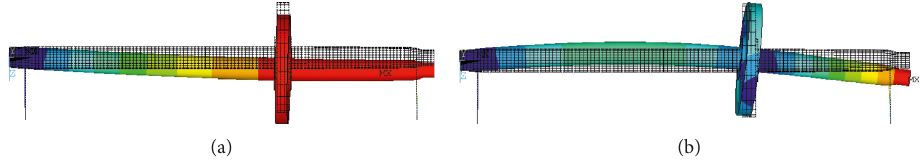
Figure 5: Mode shapes of the rotor. (a) Pitch. (b) Bending.